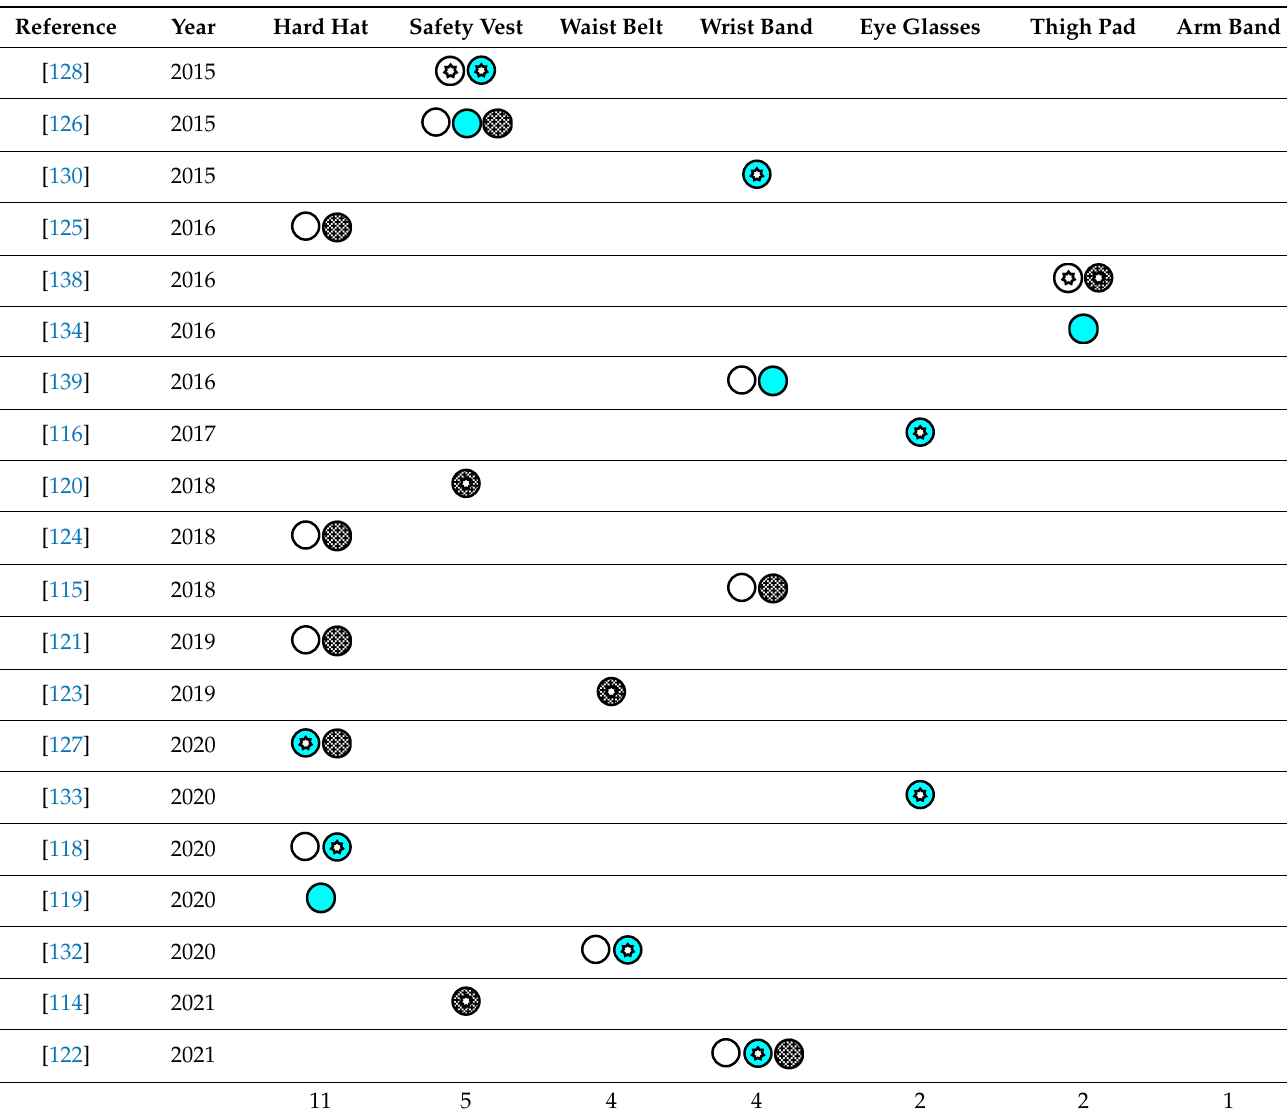
Table 3. The review criteria resulted in 29 unique research papers. A majority of these papers utilized auditory alarms (19), followed by tactile feedback (15), and visual alerts (12). Hard hat, with eleven instances, was the most frequent on-body placement. The studies conveying information beyond a binary presence or absence of hazard are recognized with a star mark - , , and , for auditory, visual, and tactile communication, respectively.